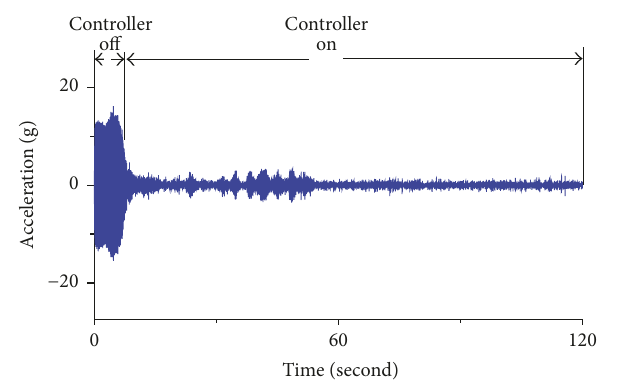
Figure 15: Time domain signal of switching control.